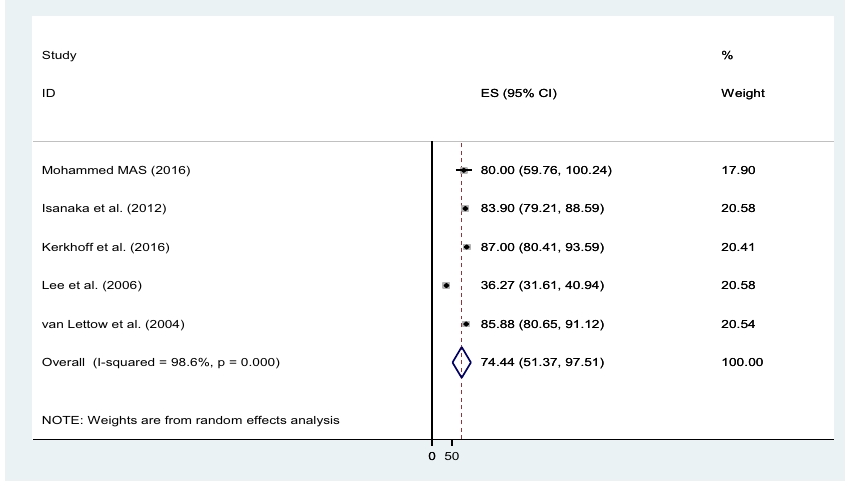
Figure 5. The pooled prevalence of anemia among female population with TB patients.